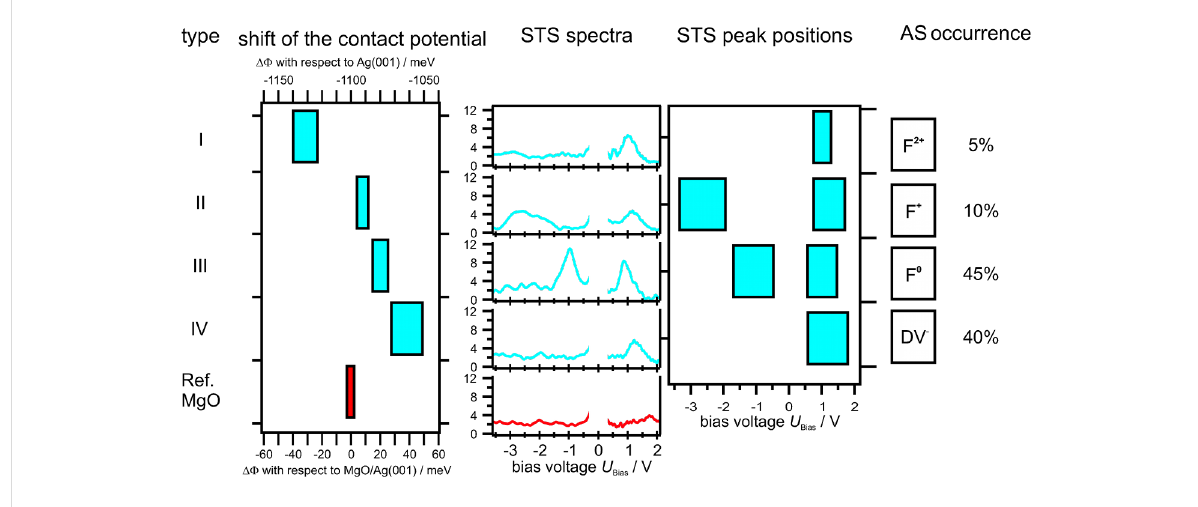
Figure 9: Color centers on MgO. The left labeling assigns numbers to the defect types. The left graph shows the relative shift of the local (effective) contact potential with respect to the MgO surface (bottom abscissa) and with respect to the Ag(001) level (top abscissa). The covered range in the shifts results from measurements with different local resolutions due to different tip structures. The energy level scheme presents the different energy levels of the defect types and their local contact potential shifts. The central graph shows STS spectra of the respective defects. The right graph presents the maxima of the STS data. The covered abscissa range accounts for the statistics of the peak positions. The assignment (AS) of defect types to color centers and negatively charged divacancies (DV − ) according to theory as well as their relative occurrence are given on the right hand side.